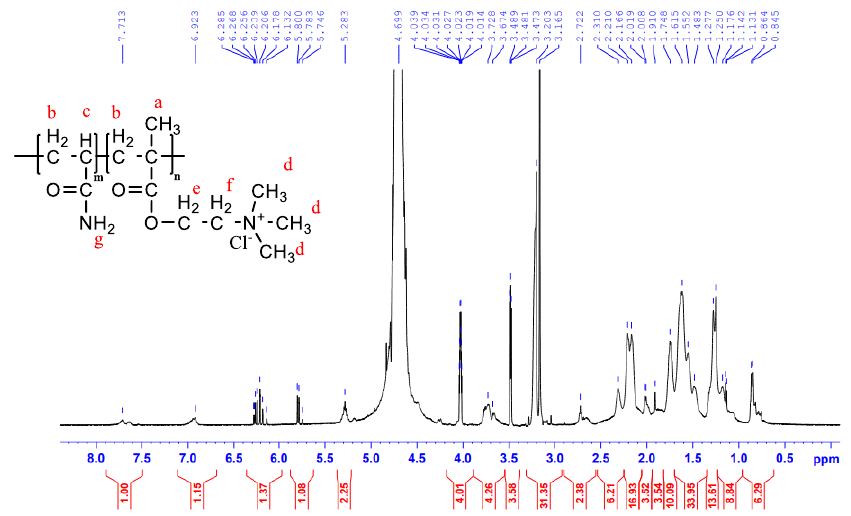
Figure 5. 1 H–NMR spectra of CPAM Figure 5. 1 H – NMR spectra of CPAM copolymers.